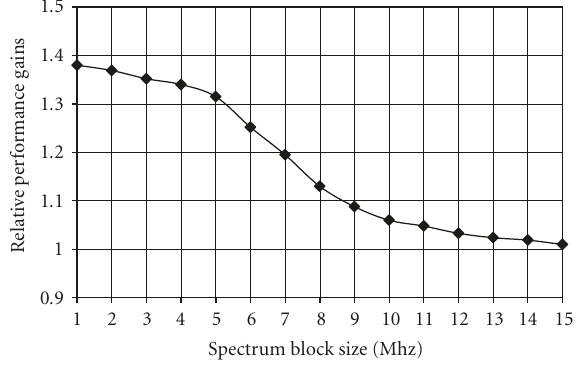
Figure 7: Comparison of the performance gains under di ff erent spectrum block size.